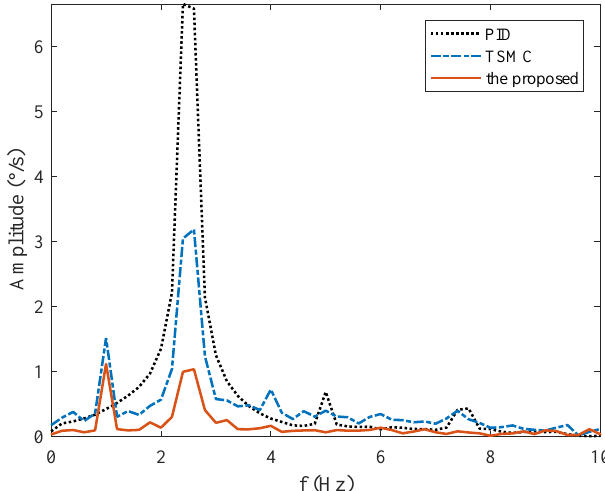
Figure 17. Frequency spectrum under Case III.